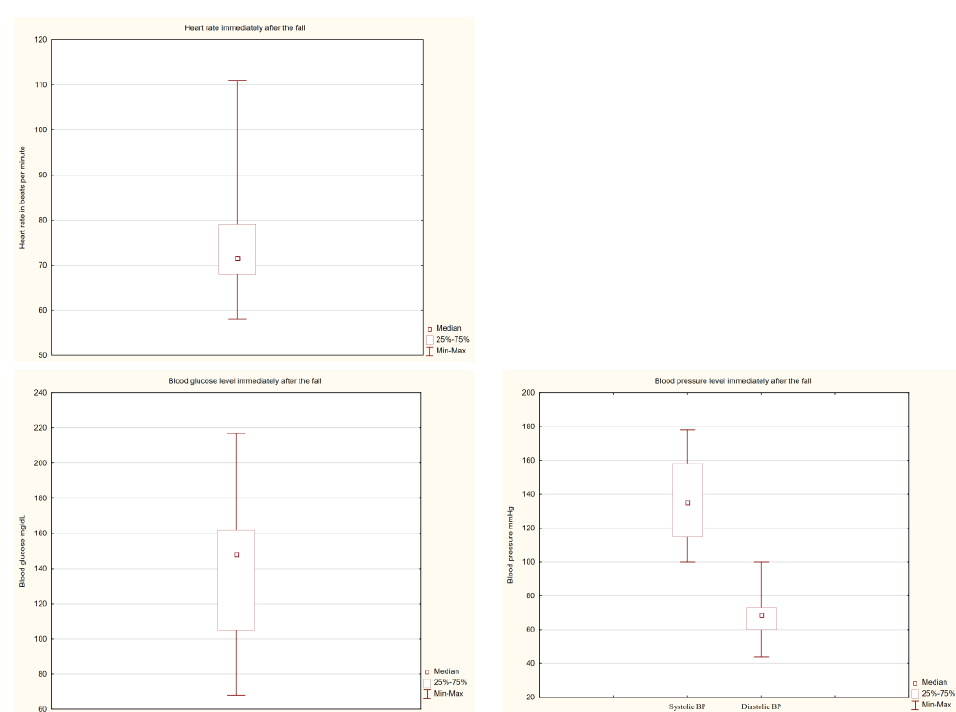
Figure 2. Basic parameters examined immediately after the fall.